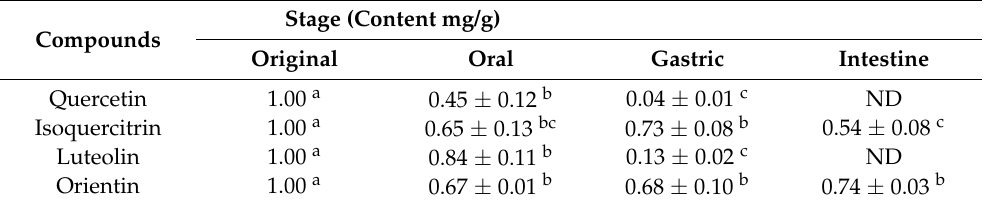
Table 1. The contents of compounds during in vitro